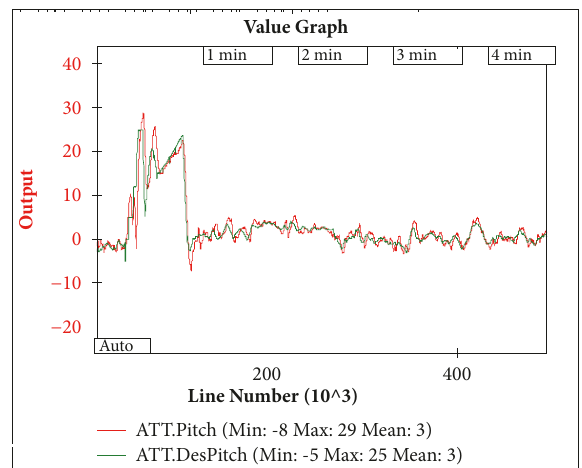
Figure 12: DTR trajectory from takeoff to horizontal flight.